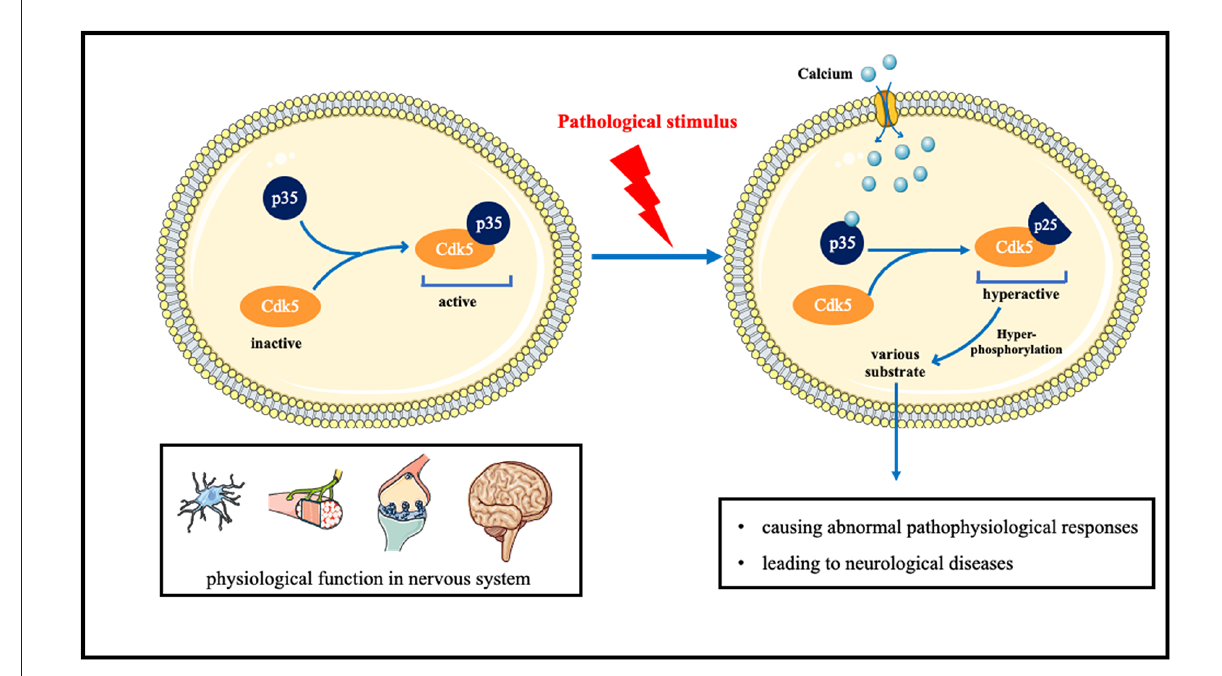
FIGURE1 The role of Cdk5 in neurological disorders and the underlying molecular mechanisms.